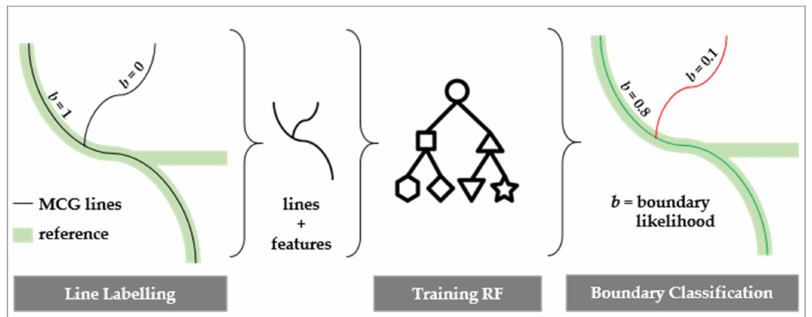
Figure 4. Boundary line classification based on Random Forest (RF) to derive boundary likelihoods for MCG lines.